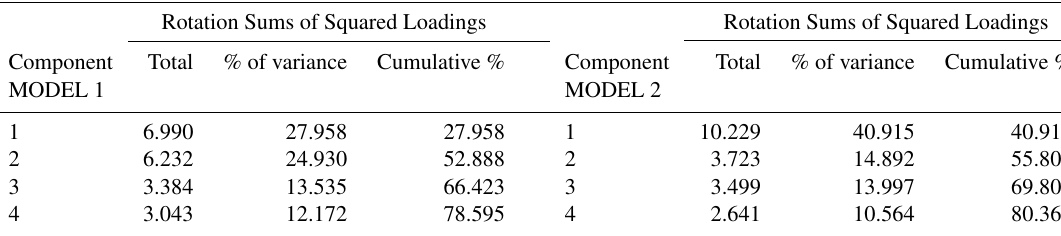
Table 5. Total variance explained in Models 1 and 2.